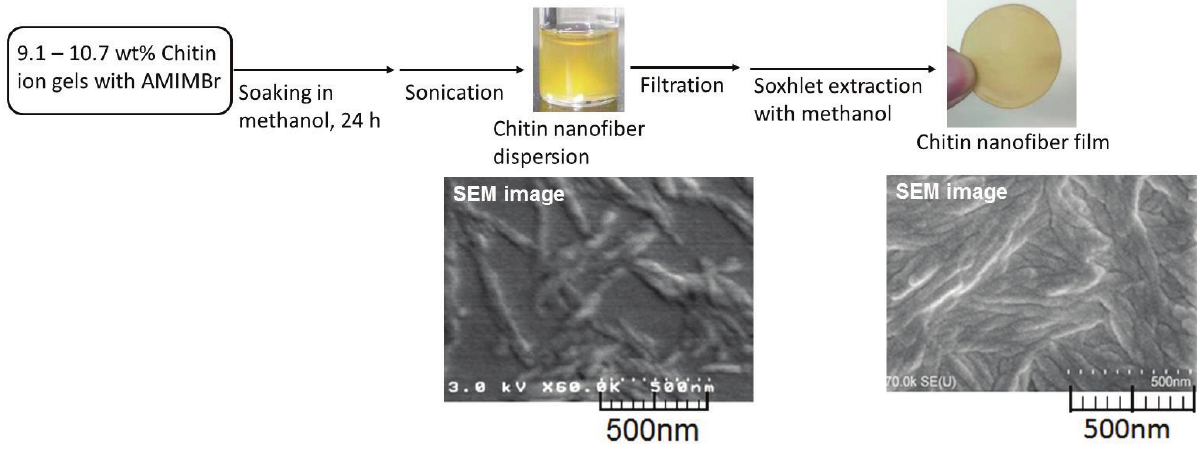
Figure 8. Procedures for fabrication of self-assembled chitin nanofiber dispersion and film, and their SEM